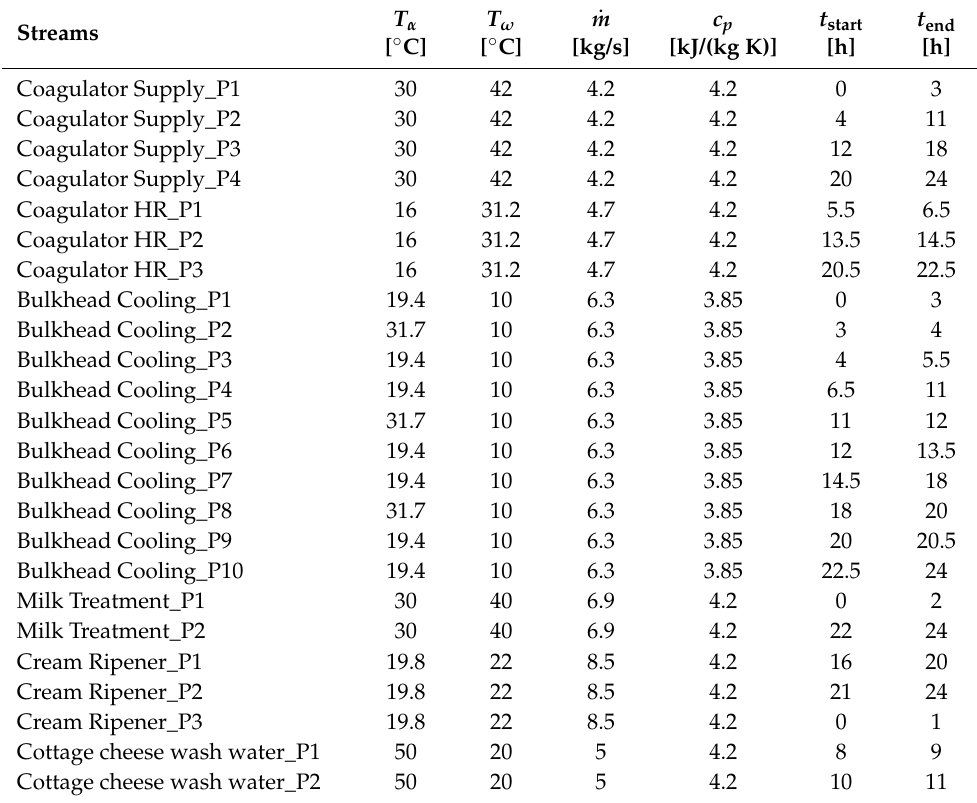
Table 3. Process stream table of Case 2. Streams with multiple periods of occurrence during one batch are denominated by the ending